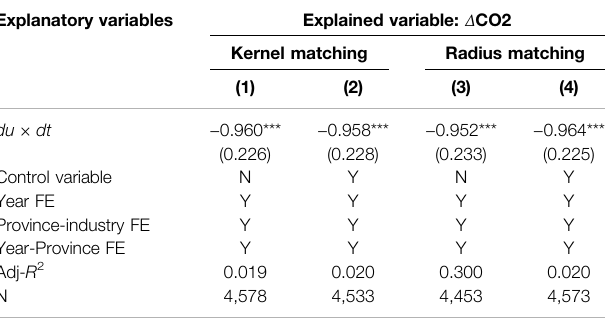
TABLE 7 | PSM-DID test.